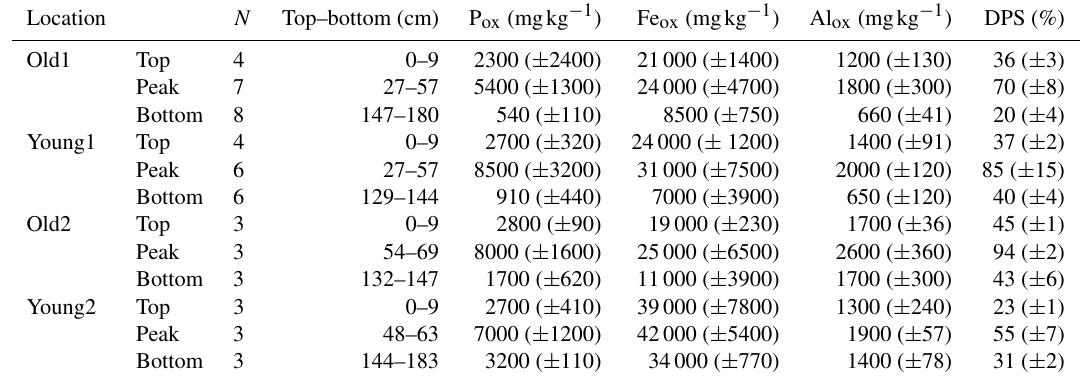
Table 1. The sediment oxalate extractable P (P ox ) and its degree of phosphate saturation (DPS) of the top, bottom, and peak sediment layers at four different tidal marsh locations. Top layers are the sediments closest to the surface, peak layers had maximal P ox and DPS, and bottom layers are those sediments sampled at the largest depth. Values of P ox and DPS are means ( ± standard deviation) of N sediment samples, between top and bottom (cm) depth.